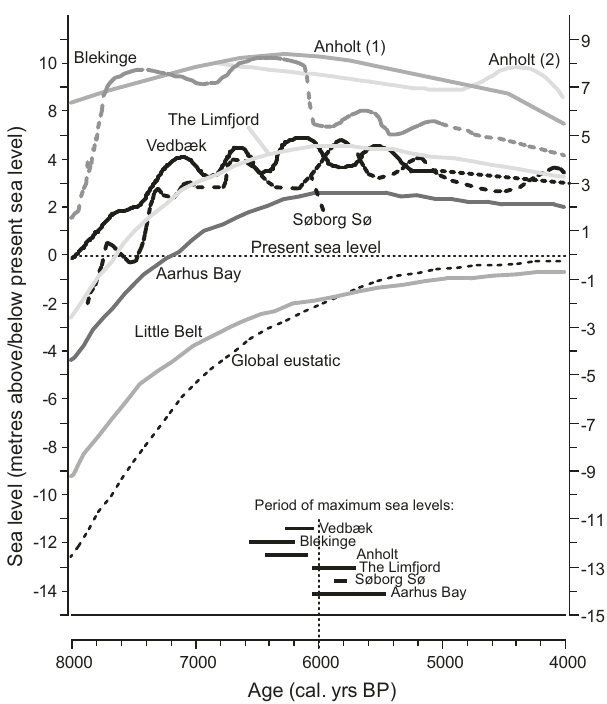
Fig. 2 Summary of available sea-level curves for Southern Scandinavia. Sea-level curves for Southern Scandinavia 7,9,20,23 – 27 are plotted on common altitude scale, with period of maximum sea-levels highlighted to show